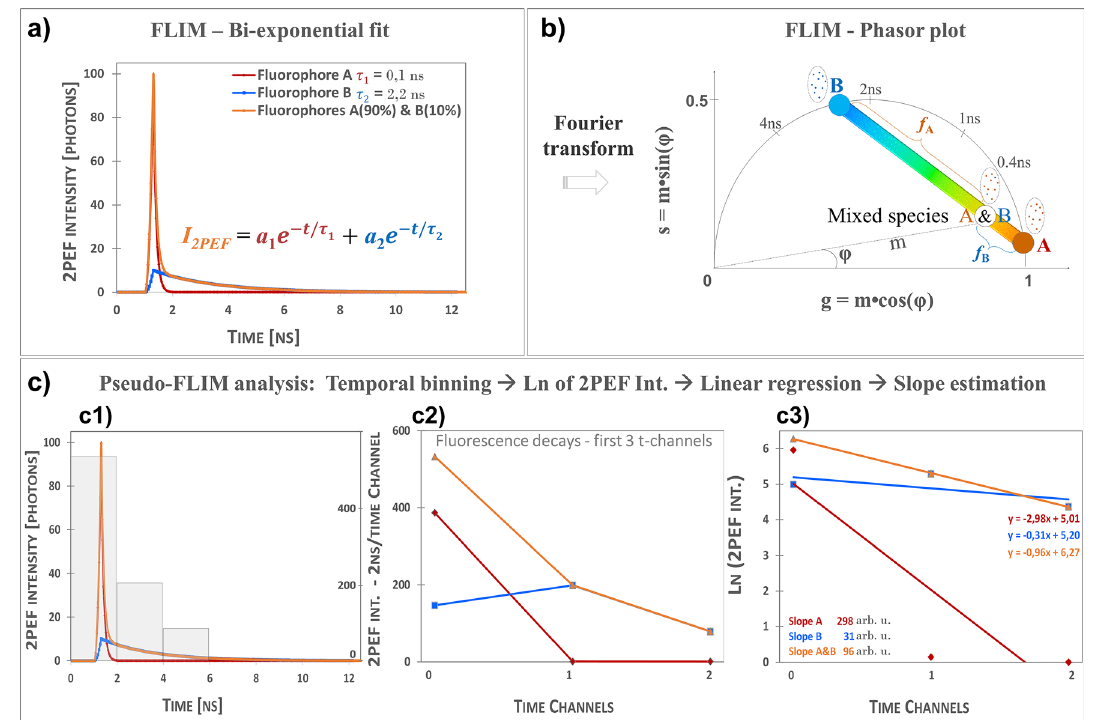
Figure 1. Principle of FLIM bi-exponential, Phasor and Pseudo-FLIM analyses. ( a ) Simulated mono- exponential (fluorophores A and B) and bi-exponential (mixed species of fluorophores A and B with respectively 90% and 10% relative contribution) two-photon excited fluorescence intensity decays (12.5 ns time range; 80 MHz); this shape of A&B bi-exponential decay can be measured in melanin containing samples. In FLIM bi-exponential analysis, the 2PEF intensity decay is adjusted with the function in ( a ) to compute the values of short- τ 1 and long- τ 2 fluorescence lifetimes and their relative contributions a 1 [%] and a 2 [%] . Images of FLIM bi-exponential fit and combination parameters such as amplitude- and intensity-weighted lifetimes are used for data analyses. ( b ) FLIM phasor analysis transforms a decay into a phasor with polar coordinates g , s , corresponding to the real and complex components of the Fourier transform, that can also be expressed as a function of m modulation and φ phase angle. Mono-exponential decays such as A and B will have their phasors on the semi-circle, whereas mixed species will have a phasor along a line connecting the two distinct lifetime phasors of A and B. The relative fractions f A and f B can be computed from the distances of A&B mixed species phasor to B and respectively A phasors. Images of g and s as well as combination parameters such as the apparent phase and modulation lifetimes and their relative fractions are used for data analyses. ( c ) Pseudo-FLIM analysis firstly involves a temporal binning of the 2PEF decay into a reduced number of time channels with 2 ns integration time per channel (see c1 , gray bars indicate the photon intensity of the mixed A&B species within the first 3-time channels with 2 ns binning). The 2PEF intensity of the binned first 3-time channels for simulated A, B and mixed A&B species is given in ( c2 ). After a natural logarithm transformation ( c3 ), a linear regression of the first 3-time channels is performed to calculate the slope of the decay which is multiplied by a − 100 factor to create the Pseudo-FLIM slope parameter. The faster the decay, the higher the slope. Pseudo-FLIM image of the slope parameter is further processed for melanin detection by applying a threshold to keep the pixels with high slope semicircle and reflects the mixed molecular species contributions. By observing the pixels clustering in the phasor plot and by mapping the clusters to their corresponding i , j pixels within the FLIM image, skin layers or cells with similar phasors can be identified. One can also use the morphological/structural tissue information to attribute the phasor cluster to a specific skin constituent (e.g. elastin within the elastic fibers). Phasor analysis was performed with SPCImage (v 8.1, Becker & Hickl, Berlin, Germany) and home-written macro with Fiji/ImageJ (W. Rasband, NIH, USA). After bi-exponential analysis, g and s parameters were cal- culated using the same fixed shift parameter for all the images and phasor plot images were color coded for τ 1 or τ 2 fluorescence lifetimes. Exported g and s images were further analyzed with the Fiji macro to calculate the phase τ ϕ and modulation τ m lifetimes. All these images were further processed for melanin quantification with Fiji. Phasor plot color coded images were modified with Fiji to change the black background color to white. Pseudo‑FLIM analysis for 2D and 3D melanin detection. FLIM images with different number of time-channels and temporal binning can be analyzed by Pseudo-FLIM for melanin detection 48,49 (see Fig. 1c). The main idea is to bin the fluorescence photons in a reduced number of time channels either at the acquisition or afterwards during processing and perform a linear regression to estimate the slope of the decay. FLIM 2PEF